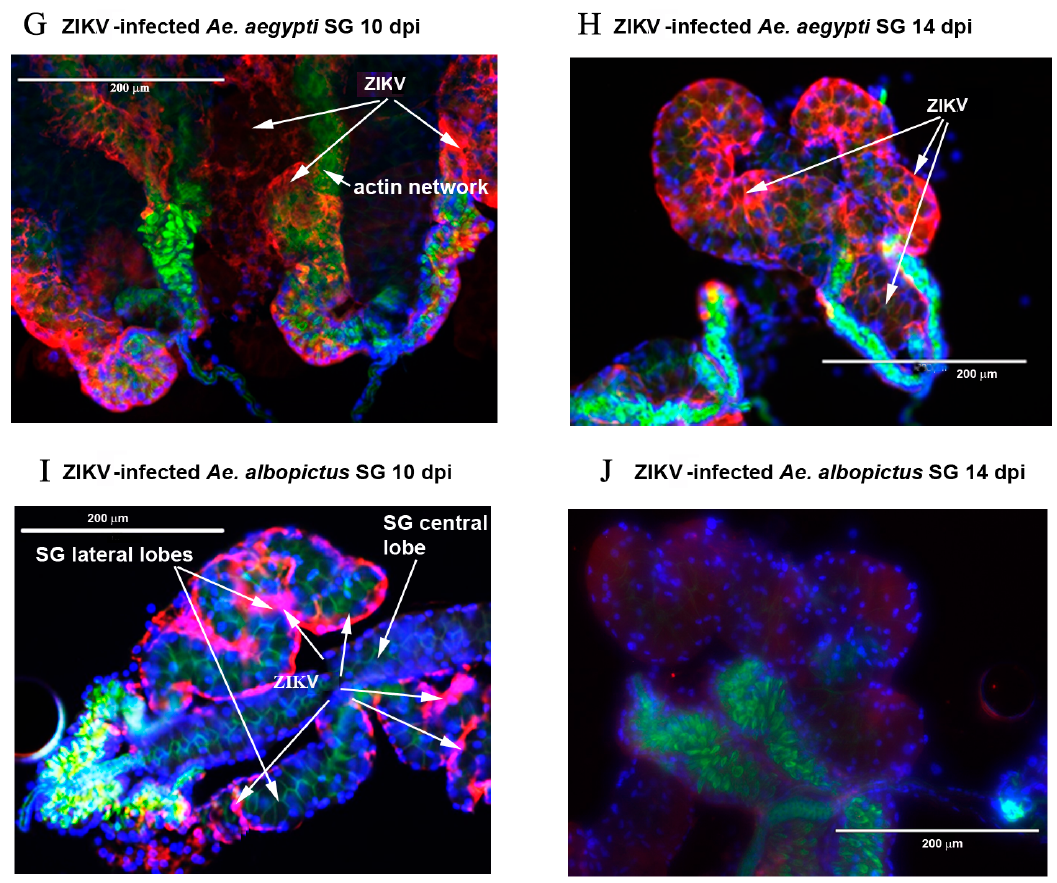
Figure 5. Dynamics of ZIKV infection in MG and SG of Ae. aegypti and Ae. albopictus at 10 and 14 dpi by microscopy. Nuclei are labeled in blue, E protein of ZIKV in red, and the actin network in green. ( A ) non-infected MG of Ae. aegypti at 14 dpi; ( B ) Non-infected SG of Ae. aegypti at 14 dpi; ( C , D ) Ae. aegypti MG infected by ZIKV at 10 and 14 dpi, respectively; ( E , F ) Ae. albopictus MG infected by ZIKV at 10 and 14 dpi, respectively; ( G , H ) Ae. aegypti SG infected by ZIKV at 10 and 14 dpi, respectively; ( I , J ) Ae. albopictus SG infected by ZIKV at 10 and 14 dpi, respectively.